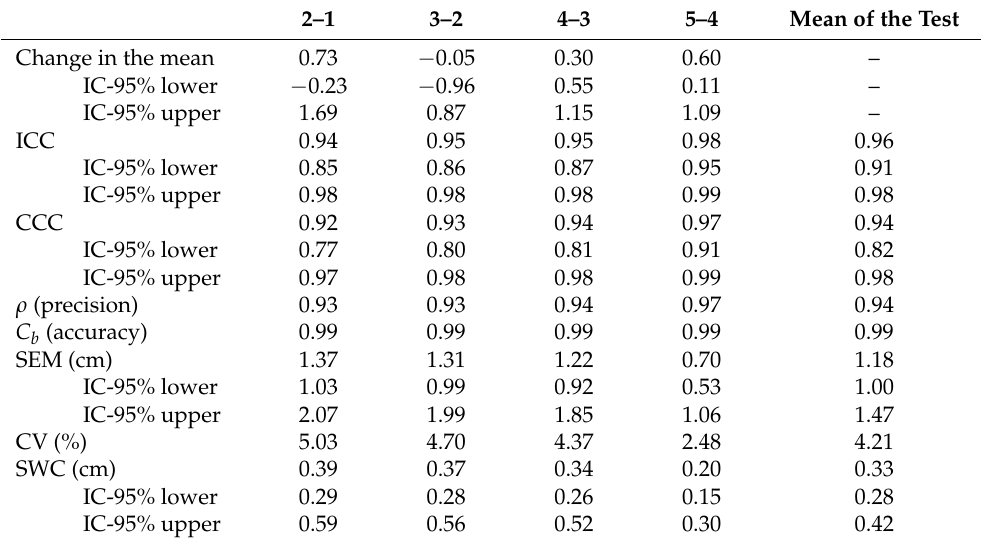
Table 2. Within-session test–retest reliability for the ADR jumping photocell between five